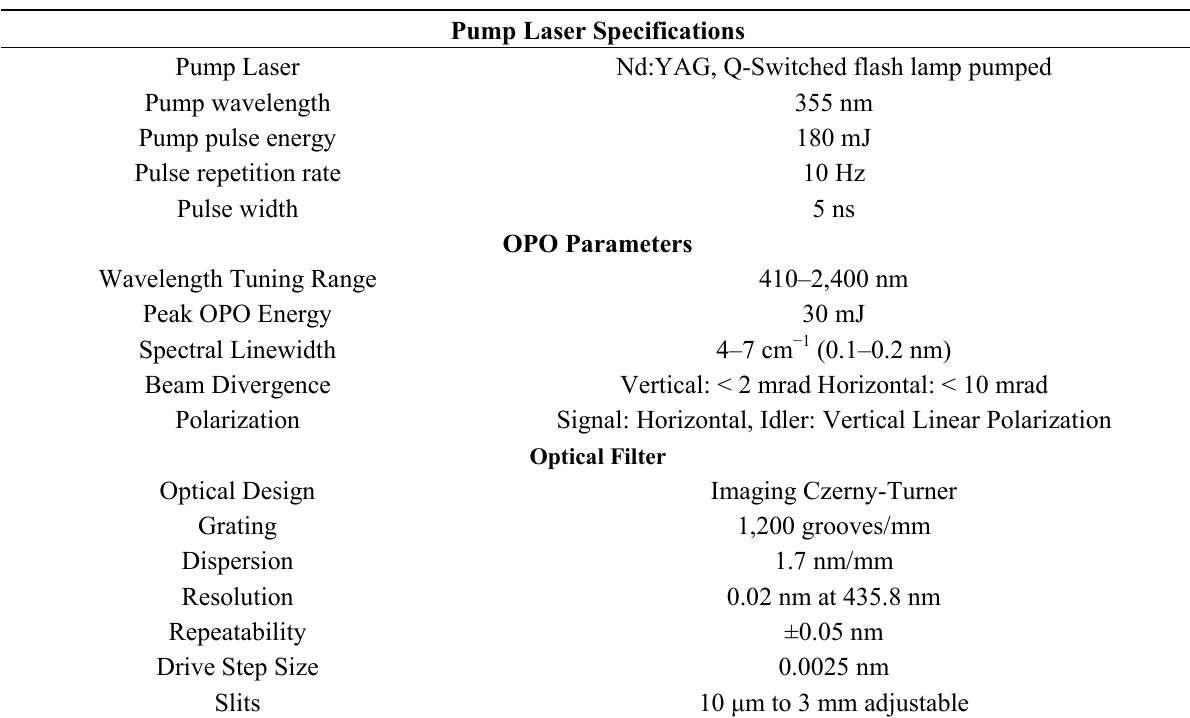
Table 1. Specifications of the Fraunhofer